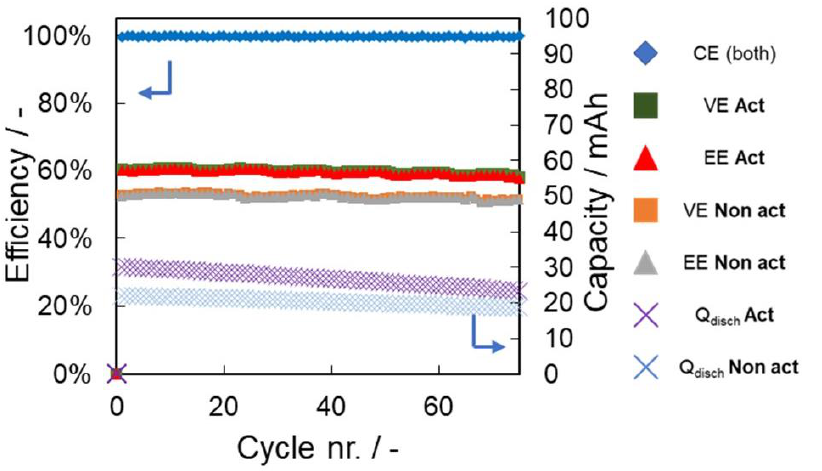
Figure 7. Comparison of the voltage and energy efficiencies for both batteries in 100 cycles at 100 mA/cm 2 . Coulombic efficiency (almost equal for both batteries): blue diamond. Voltage efficiency: green and orange squares (Na 4 [Fe(CN) 6 and AQDS as CLS, respectively). Energy efficiency: red and grey triangles (Na 4 [Fe(CN) 6 and AQDS as CLS, respectively). Discharge capacity: blue and purple crosses. (Na 4 [Fe(CN) 6 and AQDS as CLS, respectively). A total of 0.1 M AQDS in 1 M NaCl vs. 0.1 M Na 4 [Fe(CN) 6 ] in 1 M NaCl was used, using pretreated and non-pretreatead Nafion 212 ® mem- branes.